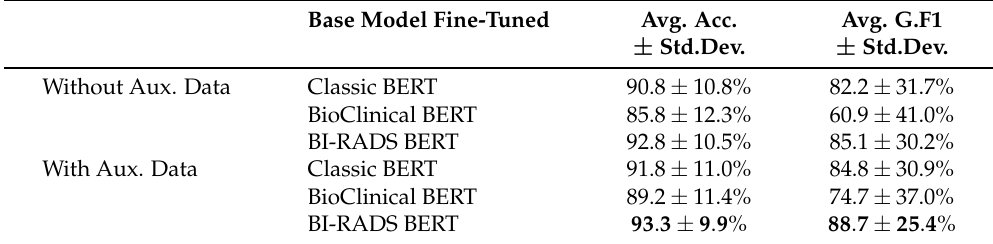
Table 3. Results of 5-fold cross validation section segmentation when trained using 10% of training data, evaluated with average accuracy with standard deviation (Std.Dev.) and average G.F1 with standard deviation (Std.Dev.) across all 900 reports used for fine-tuning. Aux. Data = the classification of the previous sentence in the report, the number of the given sentence it is classifying, and the total number of sentences in the report.